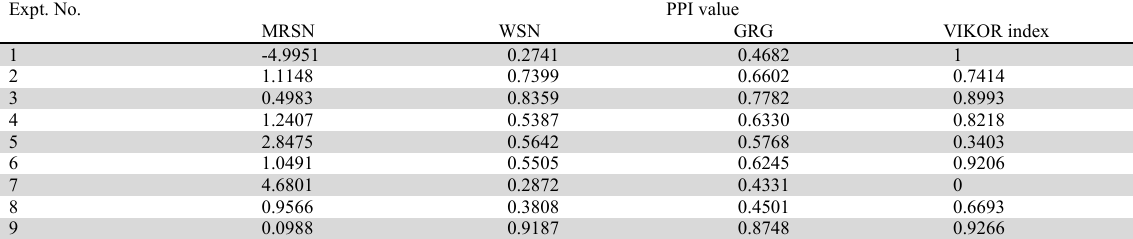
PPI values for MRSN, WSN, GRA, and VIKOR method Expt. No.